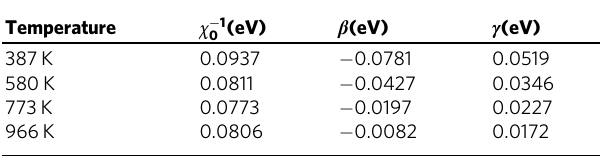
Table 3 Parameters that characterize the temperature dependence of the electronic energy as extracted by fi tting the data in Supplementary Note 1; electronic energies presented in Fig. 10.